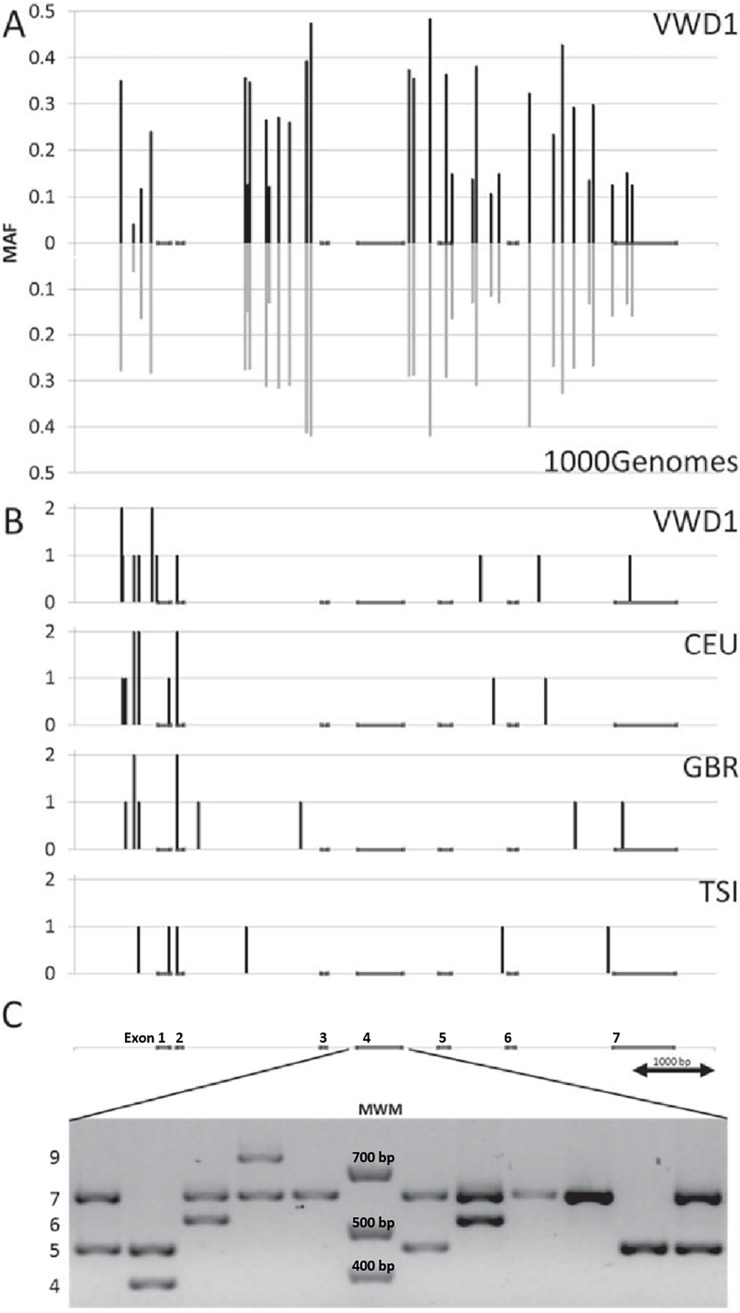
Common and rare variants in CLEC4M.(A) The positions and minor allele frequencies for common variants in CLEC4M in type 1 VWD patients (n = 106), and three 1000Genomes populations; CEU (n = 99), GBR (n = 88) and TSI (n = 107). (B) The positions and numbers of rare variants in the respective populations. (C) VNTR genotypes showing all common alleles.